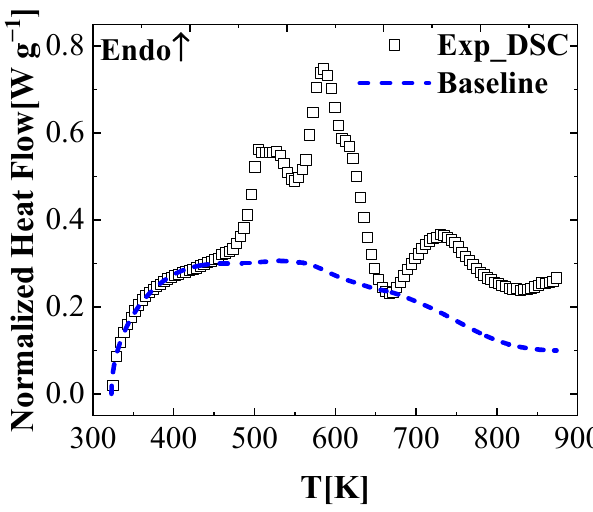
Figure 6. Heat flow baseline calculated for the FR_PU_aerogel using Equation (20). Using all of the reaction mechanisms, kinetics, heat capacities of the condensed phase components, and the heat of the reactions, the experimental DSC data can be reproduced. A comparison of the experimental normalized heat flow history and modeling results obtained from the ThermaKin2Ds simulations is shown in Figure 7a. Overall, a good agreement was achieved except for the underestimation of the final part (larger than 790 K). It is noted that at a high temperature, the heat flow sensitivity of the instrument is not very high, which can be seen from the large fluctuations of the experimental data in Figure 7. The parameterized reaction mechanism was further verified by comparing the ThermaKin2Ds calculated heat flow with the heat flow data of the DSC experiments. The experimental DSC data and the simulated data are integrated by time, and plotted as a function of the sample temperature in Figure 7b. The experimental and simulated heat flow integrals match very well.